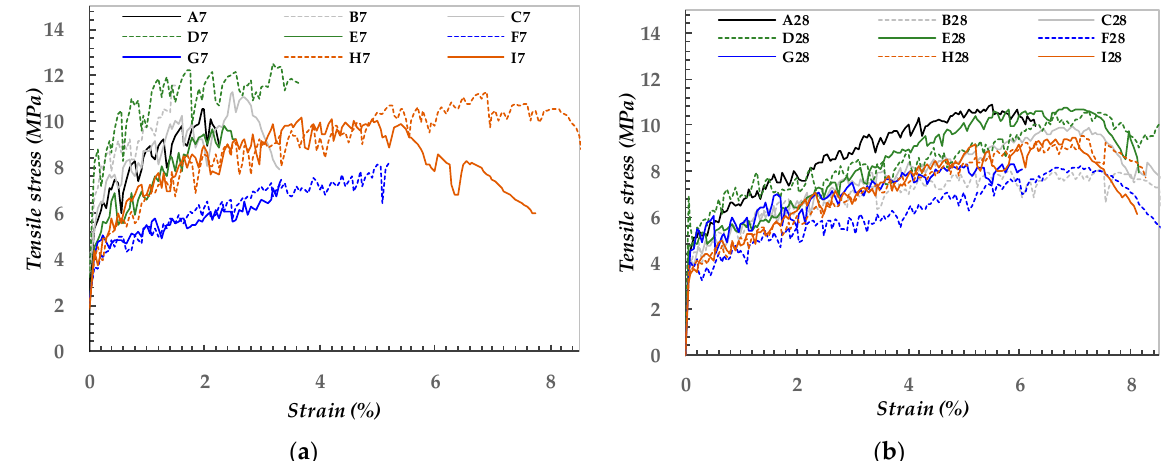
Figure 10. Tensile stress–strain curves of ( a ) 7 d and ( b ) 28 d cured specimens.